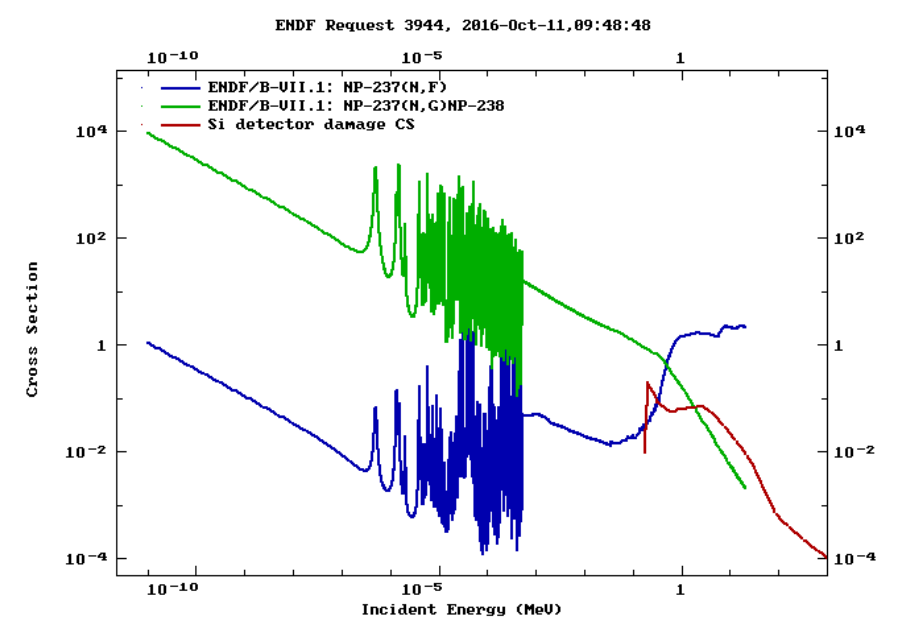
Figure 2. Cross section of neutron inducing damage in the silicon detector (red curve) and cross sections of neutron inducing fission and capture on Np-237 minor